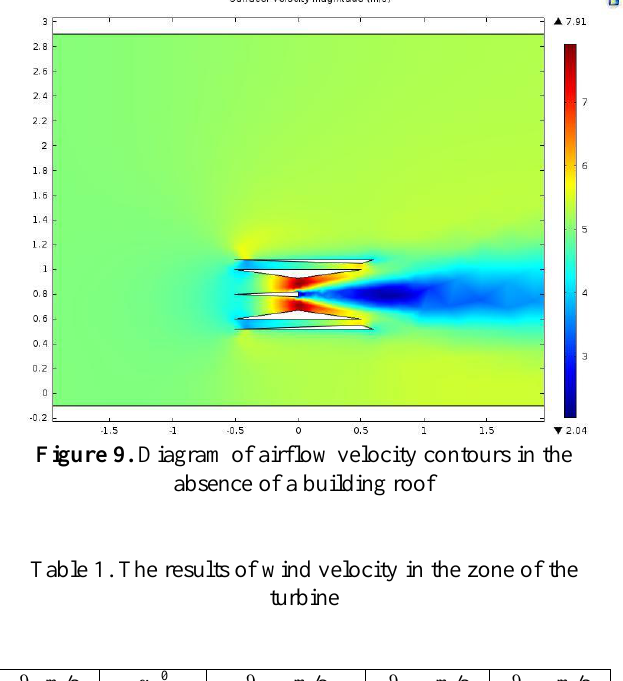
Figure 8. Diagram of airflow velocity contours in the absence of an ejector